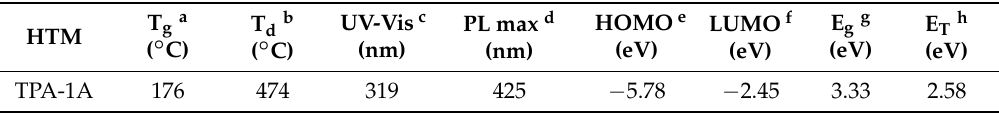
Table 1. Thermal, photophysical, and electrochemical properties of 4-(9,9-Diphenylacridin-10(9H)yl)-